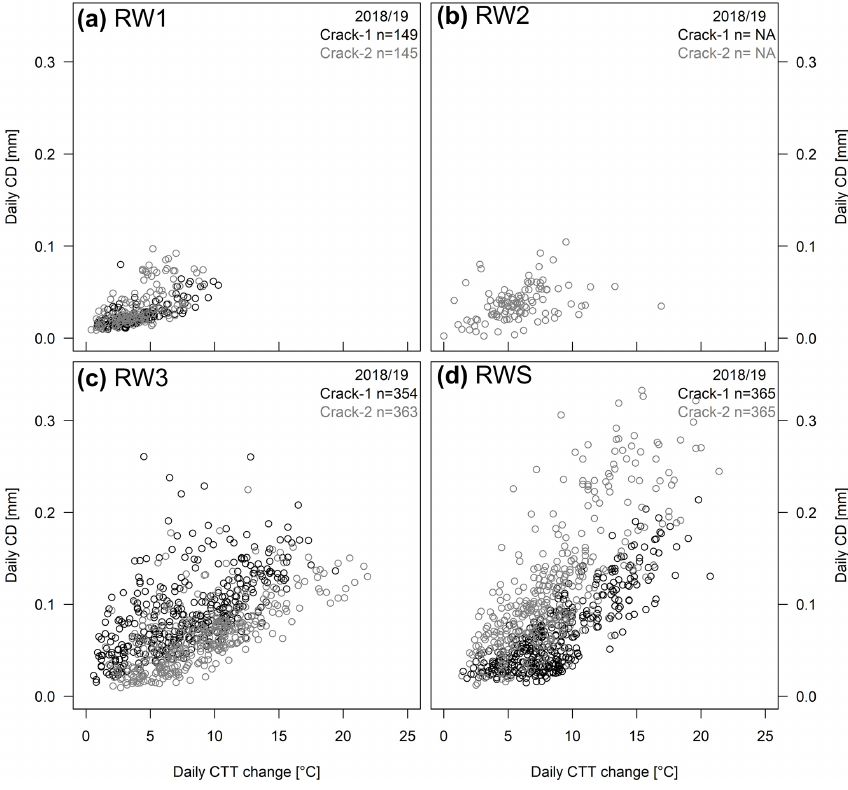
Figure 9. Daily crack deformation plotted versus daily crack-top temperature for (a) RW1, (b) RW2, (c) RW3 and (d) RWS in 2018/19. Numbers n indicate the number of daily cycles; NA highlights incomplete measurements during the period due to instrument failure. For the results of all periods, see Fig. S5 in the